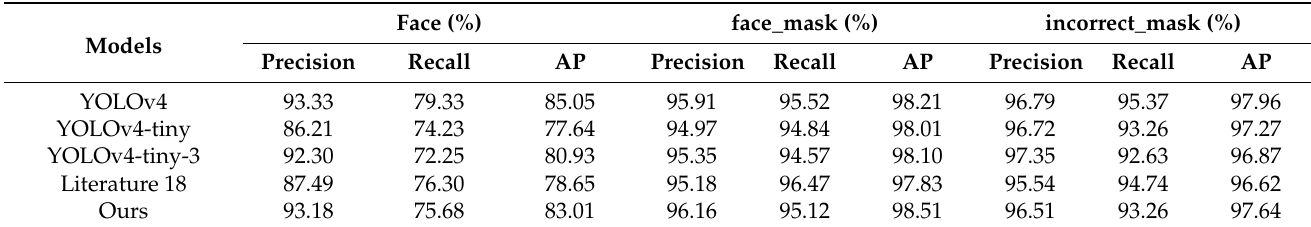
Table 2. Precision, recall and AP values for different targets of different networks.